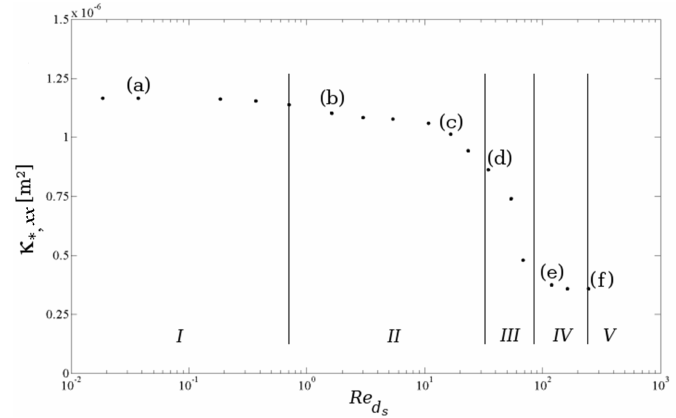
Figure 7. Permeability ( κ ∗ , xx ) versus Reynolds number for Foam 1 in Table 1. The five flow regimes are indicated (I–V).